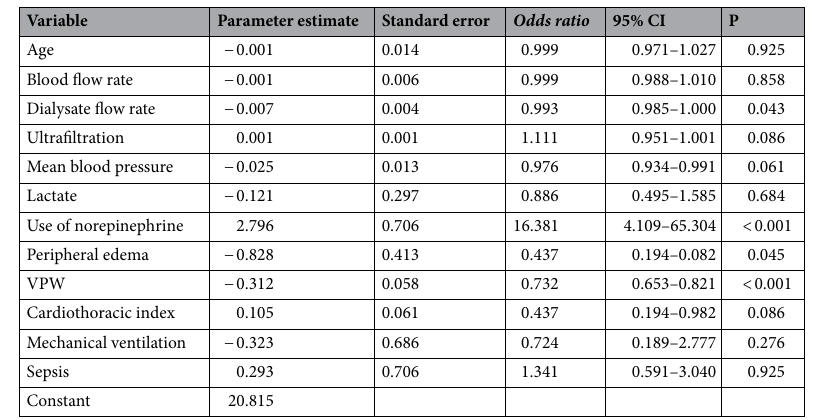
Table 2. Multivariate logistic regression of the variables significant in univariate analysis in the patients with hypotension. VPW vascular pedicle width.